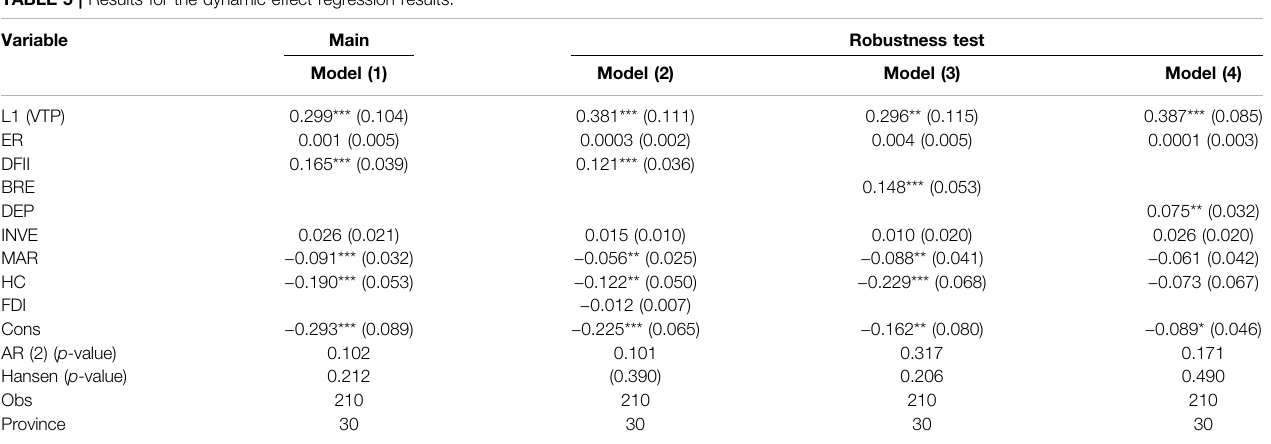
TABLE 5 | Results for the dynamic effect regression results.